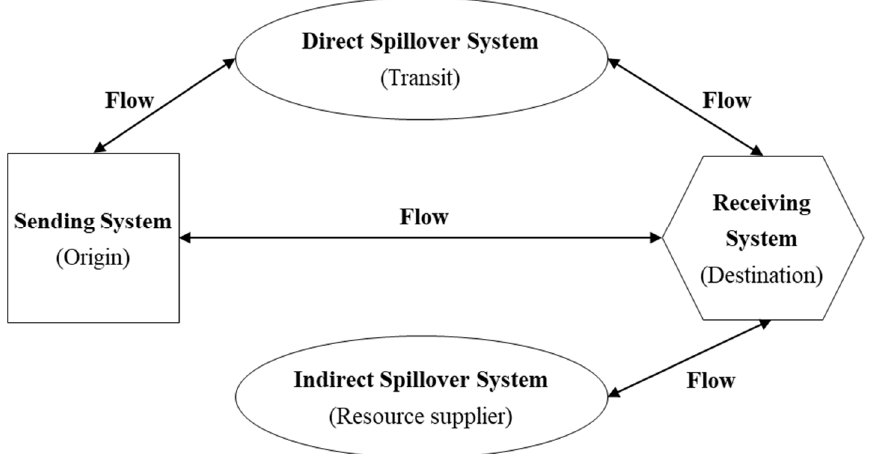
Figure 1. Framework of the tourism telecoupling system.